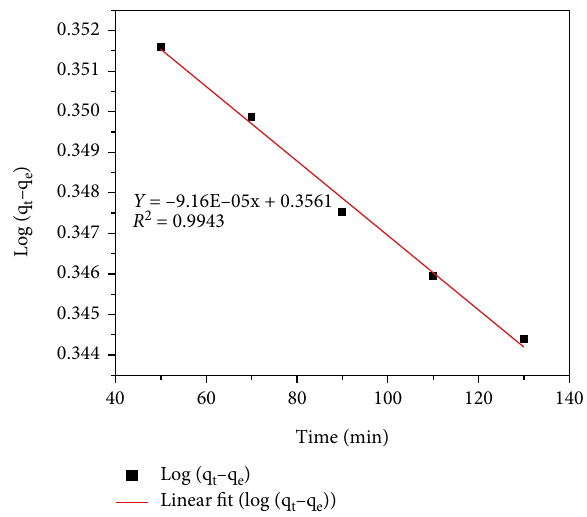
Figure 15: First-order kinetics model for adsorption of Pb (II) on CMNB at pH of 6, initial concentration of 100mg/L, and adsorbent dosage of 0.9 g\L.